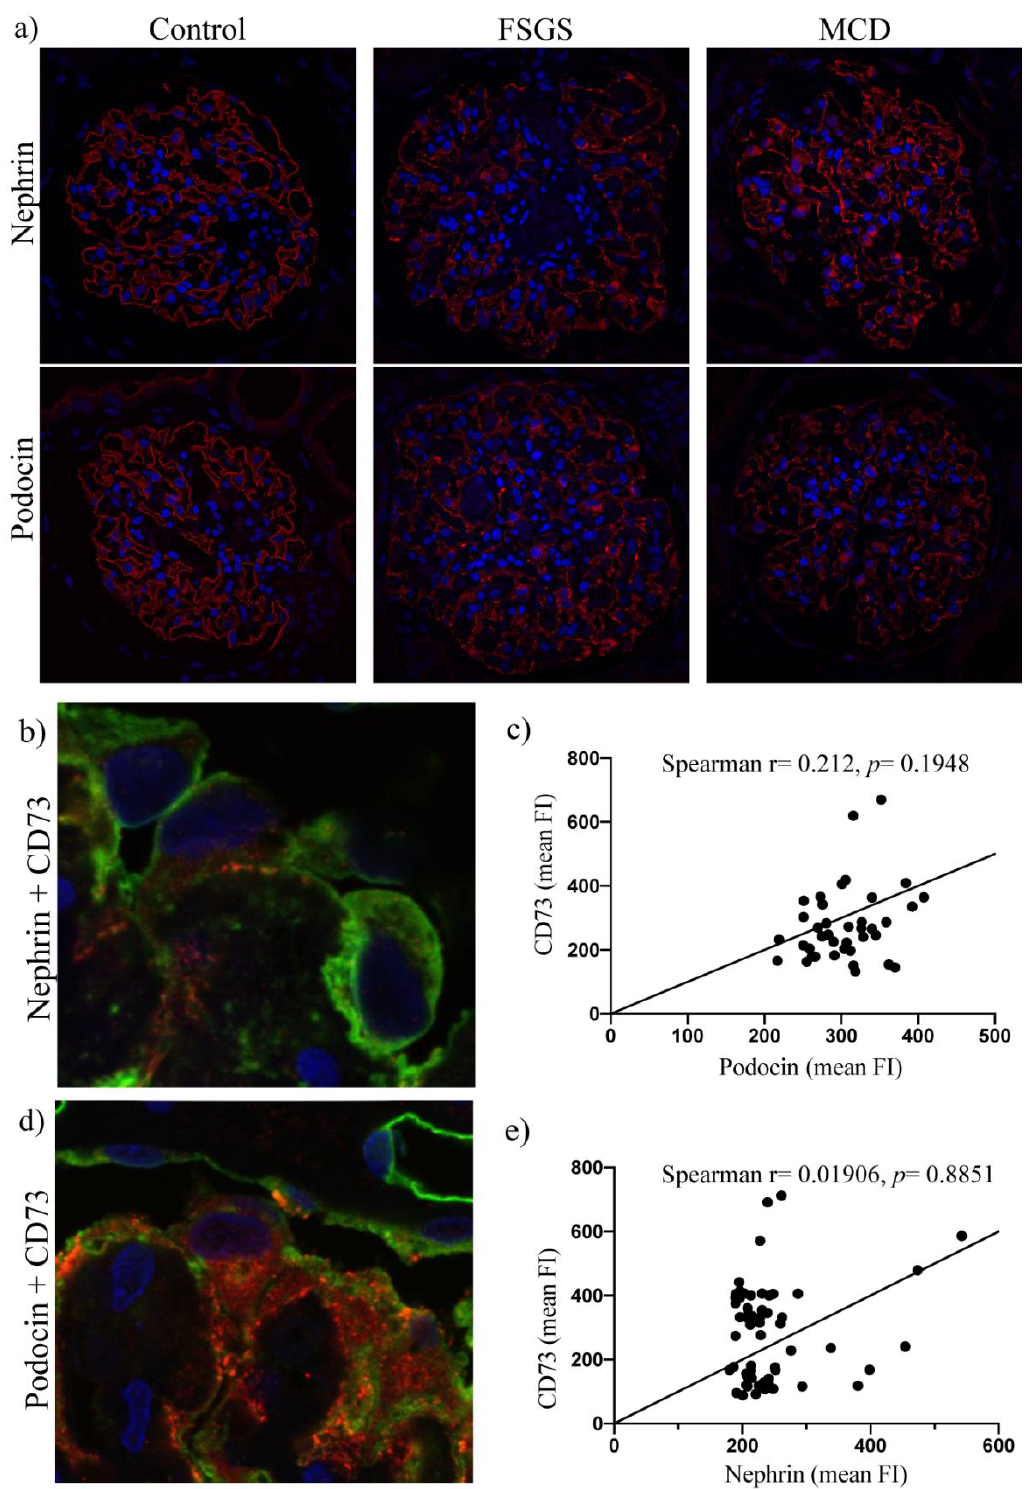
Figure 6. ( a ) In glomeruli with healthy podocytes, a uniform linear staining pattern of nephrin and podocin in the area of glomerular basement membrane can be seen (left). In contrast, glomeruli with damaged podocytes show a pathologic, granular staining pattern of podocyte-specific proteins (mid and right). ( d ) Co-stainings of podocyte-lesion samples show no significant correlation regarding mean fluorescence intensity (( c , e ) Spearman non-parametric correlation test; n = 38; two-tailed p value, confidence interval 95%. p > 0.05—no significant correlation). CD73 (green)—nephrin (red) ( b ) and CD73 (green)—podocin (red).